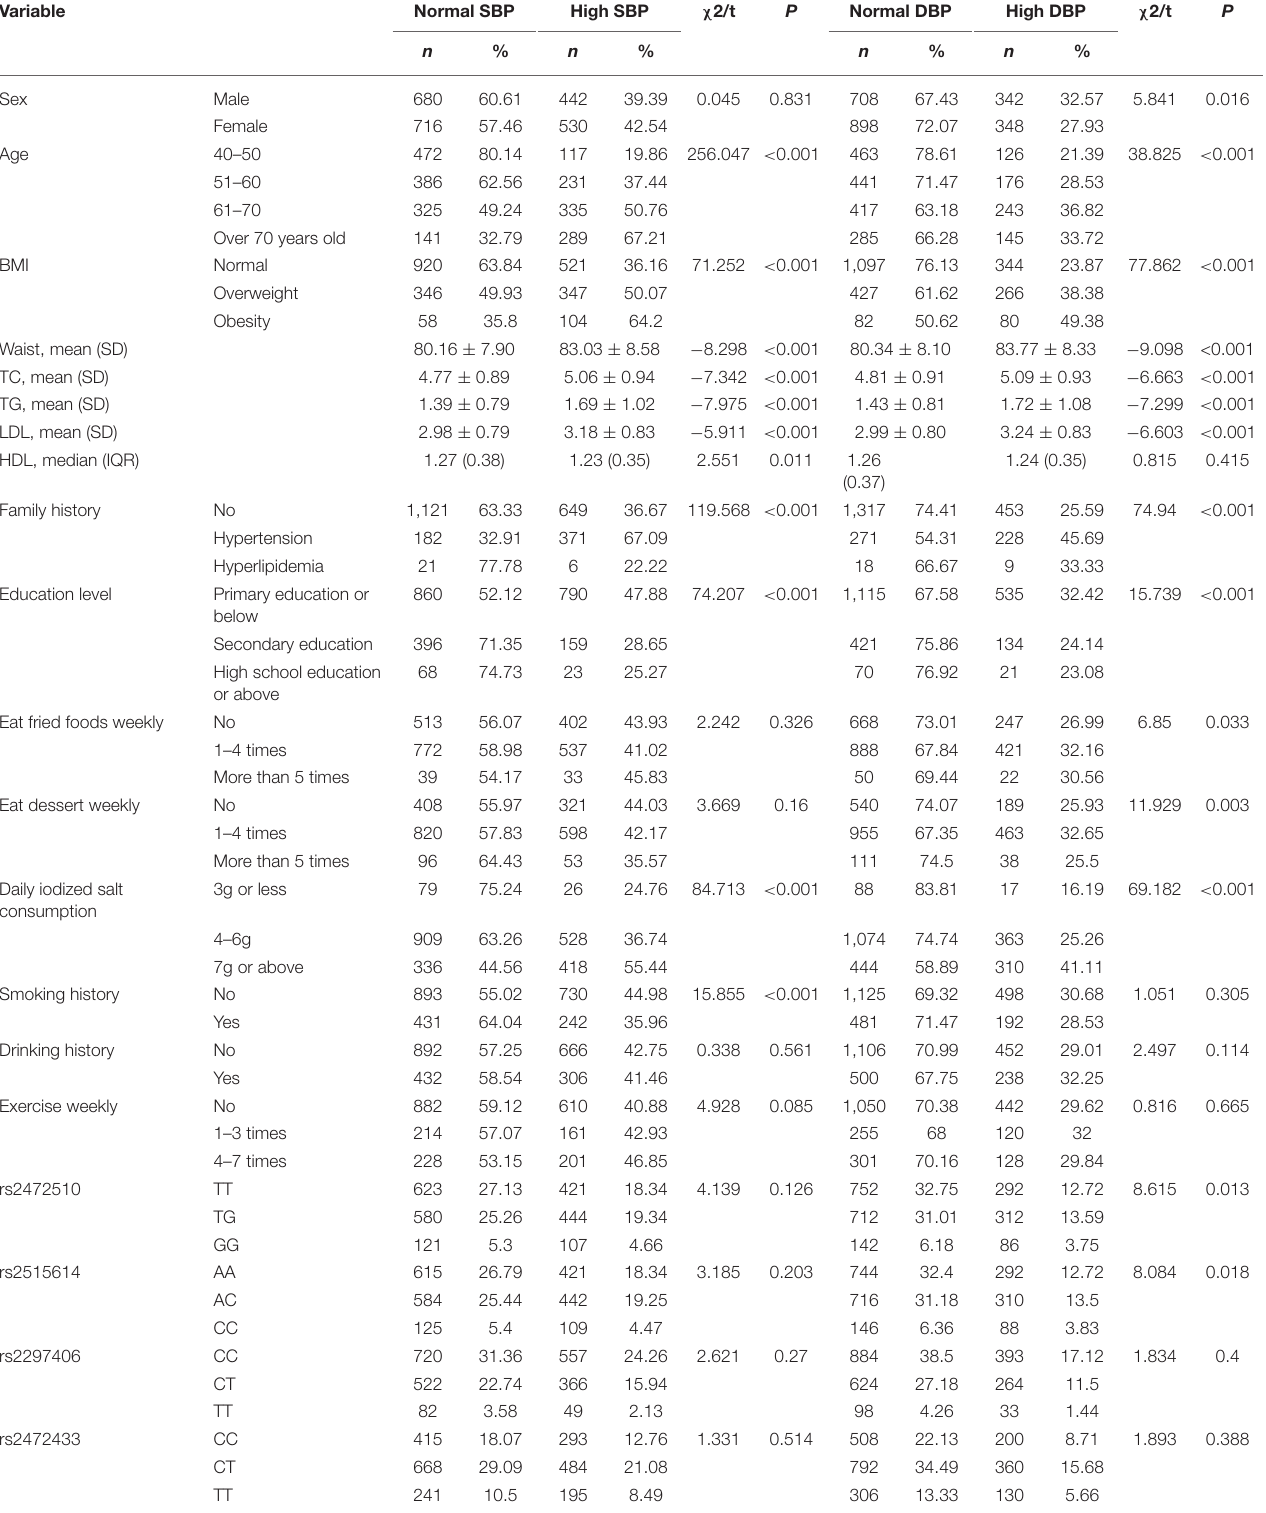
TABLE 2 | General characteristics and lifestyle factors between case and control groups.